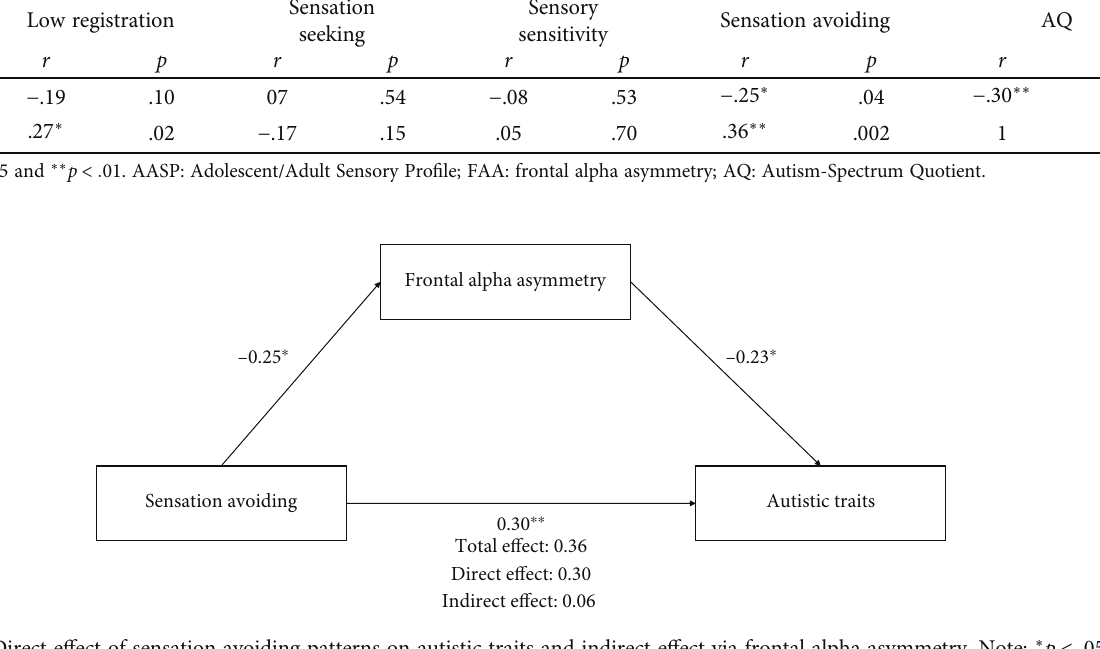
Figure 1: Direct e ff ect of sensation avoiding patterns on autistic traits and indirect e ff ect via frontal alpha asymmetry. Note: ∗ p < : 05 and ∗∗ p < : 01